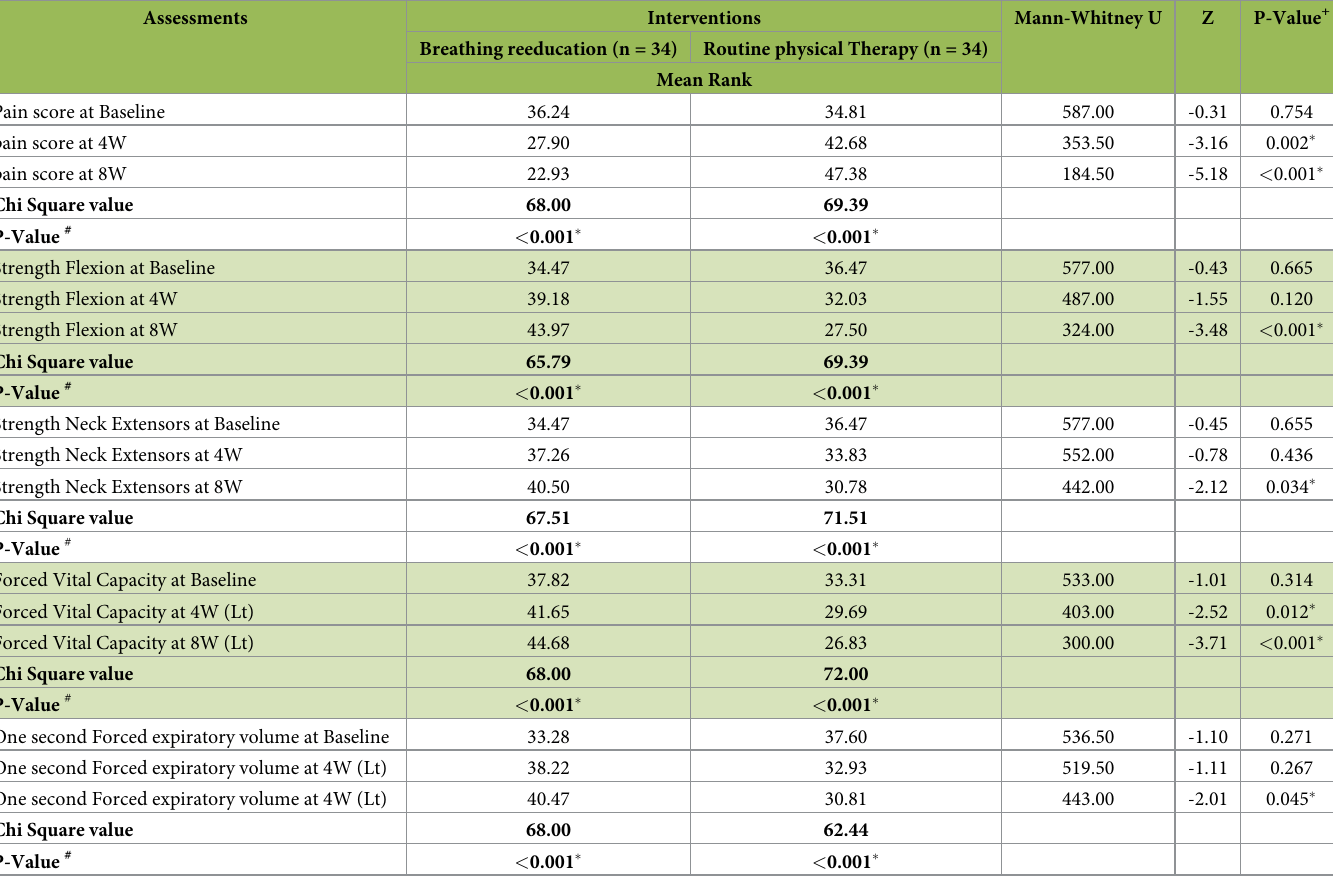
Table 5. Between and within group comparison for pain, strength of cervical flexors and extensors, FVC and FEV1 at baseline, 4 th week and 8 th week.